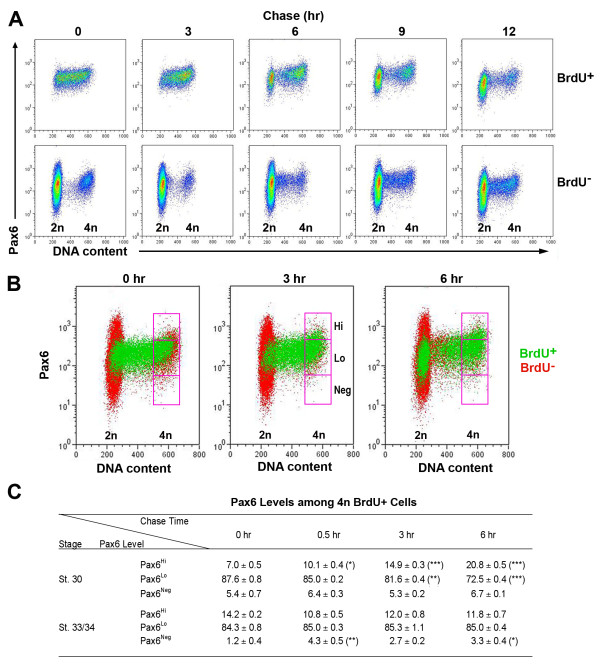
Divergence of Pax6 protein expression in the G2/M phase of the cell cycle. (A) Flow cytometric analyses of BrdU, Pax6, and DNA content among E6.5 (HH stage 30) retinal cells after a 20-minute BrdU pulse labeling. Cell density profiles of BrdU+ (upper row) and BrdU- (lower row) cells at various post-chase times are shown. The 0 hour point represents the time when cells are dissociated after the pulse label and then fixed and processed for flow cytometry. Each data point represents a minimum of 30,000 cells analyzed. The x-axis represents DNA content for G0/G1 (2n), S (between 2n and 4n), and G2/M (4n) phase cells. (B) Merged flow cytometry profiles for BrdU+ (green) and BrdU- (red) cells at 0, 3, and 6 hours post-BrdU pulse labeling. The purple frames subdivide G2/M phase cells (4n) according to Pax6 levels into high (Hi), low (Lo), and negative (Neg) categories. Between 0 and 6 hours of chasing, Pax6Hi cells clearly increased, demonstrating the Pax6 level divergence when cells enter the G2/M phase. (C) Quantification of Pax6 levels at stage 30 (E6.5) and stage 33/34 (E7.5 to 8) among BrdU+ cells that had entered G2/M phase (4n) as shown in the three boxed regions in (B). The percentages of 4n BrdU+ cells with Pax6Hi, Pax6Lo, or Pax6Neg levels among total 4n BrdU+ cells at various post-chase times are shown (N = 3; mean ± standard error). Asterisks represent P-values between 0 hours and various chase time points: *P < 0.05; **P < 0.01; ***P < 0.001.